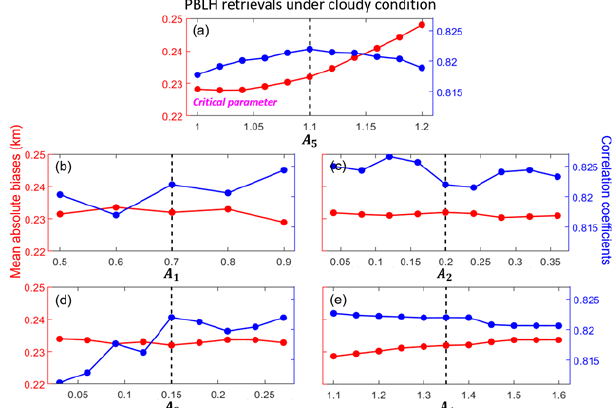
Figure 7. Red lines indicate the mean absolute biases between PBLH derived from lidar and radiosonde for selecting different val- ues of empirical parameters ( A 1 , A 2 , A 3 , A 4 , A 5 ) in the DTDS algorithm. Here, we only analyze the low-cloud cases. Blue lines in- dicate the corresponding correlation coefficients between PBLH de- rived from lidar and radiosonde. Dashed black lines indicate the de- fault values. For each test, one parameter is variable, while other pa- rameters are set as default values. For PBLH retrievals under cloudy conditions, A 5 is the critical parameter.